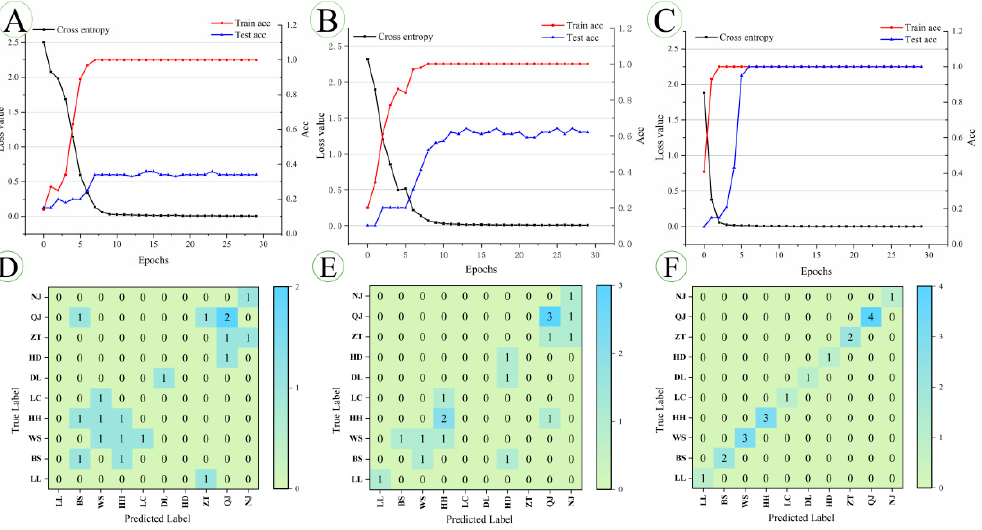
Figure 8. ( A ) (Original), ( B ) (MSC + SD), and ( C ) (Synchronous 2DCOS) are the accuracy curves and cross-entropy cost function curves of the training set and test set of the ResNet model. ( D ) (Original), ( E ) (MSC + SD), and ( F ) (Synchronous 2DCOS) is an externally validated confusion matrix. Table 4. Parameters of ResNet Model Based on FT-NIR . Dataset